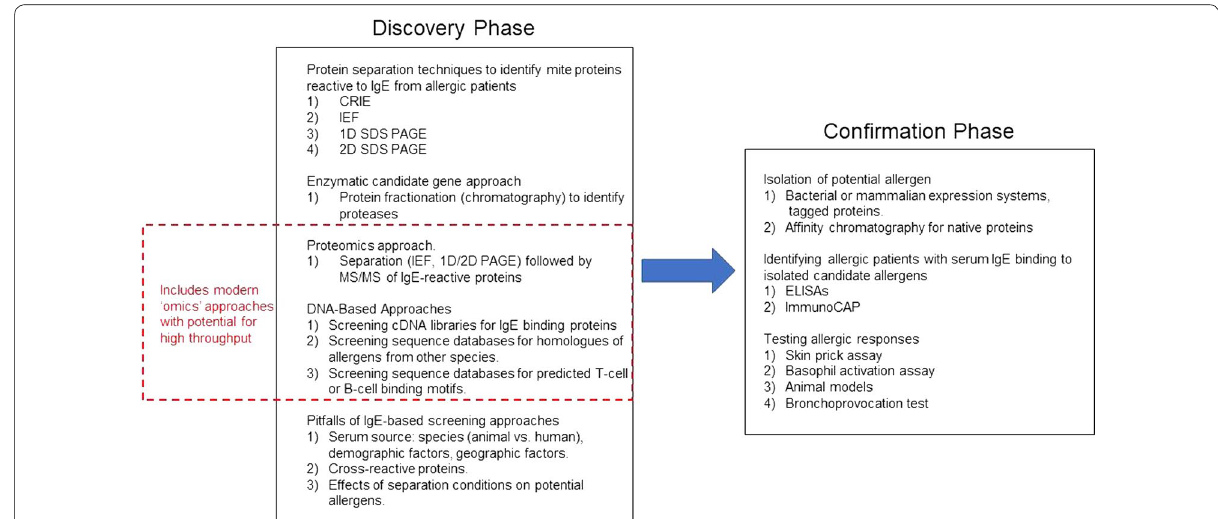
Fig. 1 Flowchart summarizing the organization of the review. Identifying allergenic mite proteins typically involves the discovery of a candidate protein (generally based on its ability to bind IgE from sera of allergic patients) followed by confirmation of the isolated protein’s ability to induce an allergic response. The major group 1 mite allergens are serine proteases, which inspired efforts to identify additional proteases with potential